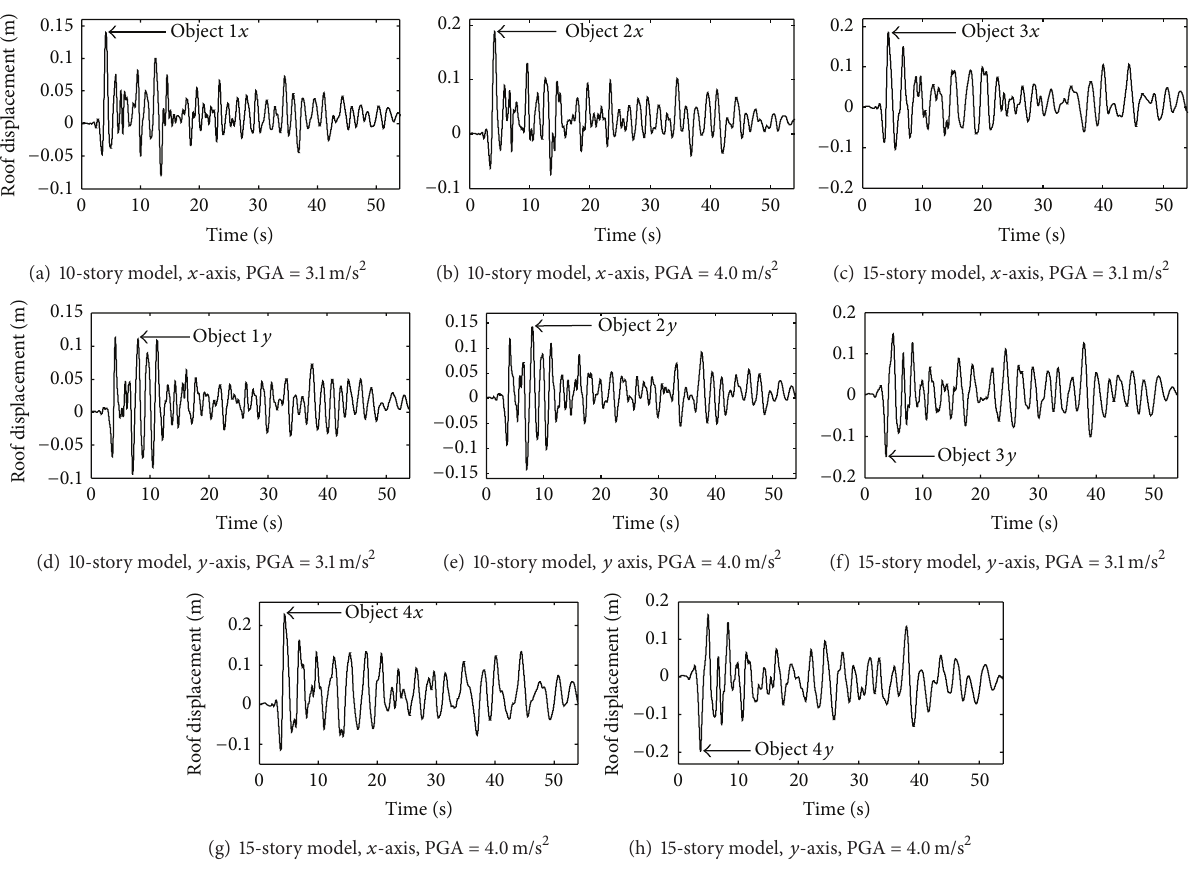
Figure 5: Displacement of roof of the structural